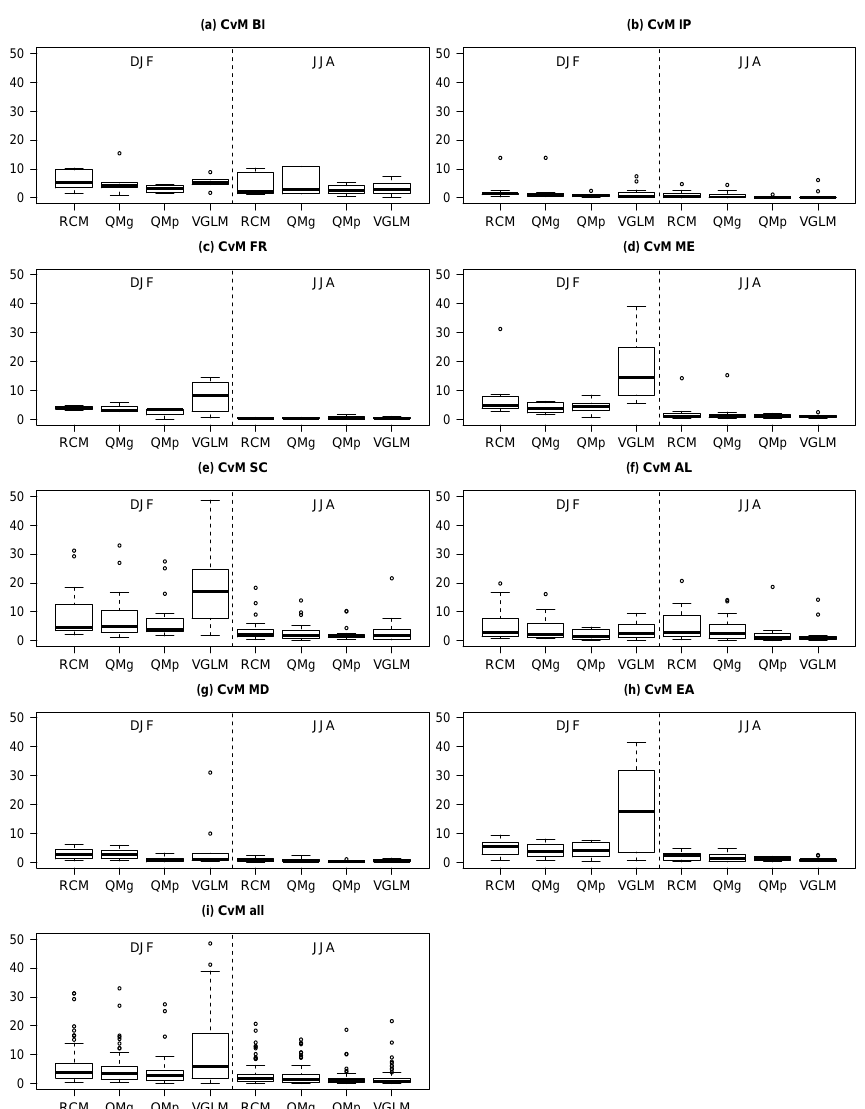
Figure 11. Intercomparison of all cross-validated models (not only the selected best model). Models: uncorrected RCM, QM grid -corrected RCM to grid scale, QM point -corrected RCM to point scale, and predictor and VGLM-downscaled RCM. Boxplots of the CvM score for all models in different subregions: (a) British Isles (BI), (b) Iberian Peninsula (IP), (c) France (FR), (d) Mid-Europe (ME), (e) Scandinavia (SC), (f) Alps (AL), (g) Mediterranean (MD), (h) eastern Europe (EA), and (i) all locations. For the VGLM the CvM score was computed for 100 realizations and then averaged. Outlier out of range in (d, i) RCM DJF: